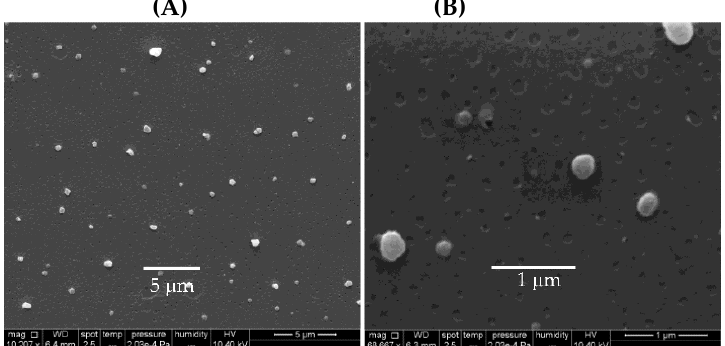
Figure 9. Scanning electron micrographs of PDDA/OVA NPs assembled at 0.1 mg·mL −1 OVA and 0.01 mg·mL −1 PDDA obtained under low ( A ) and high magnification ( B ). At the low PDDA dose employed, PDDA cytotoxicity was not significant against cells in culture. Reprinted from [65].